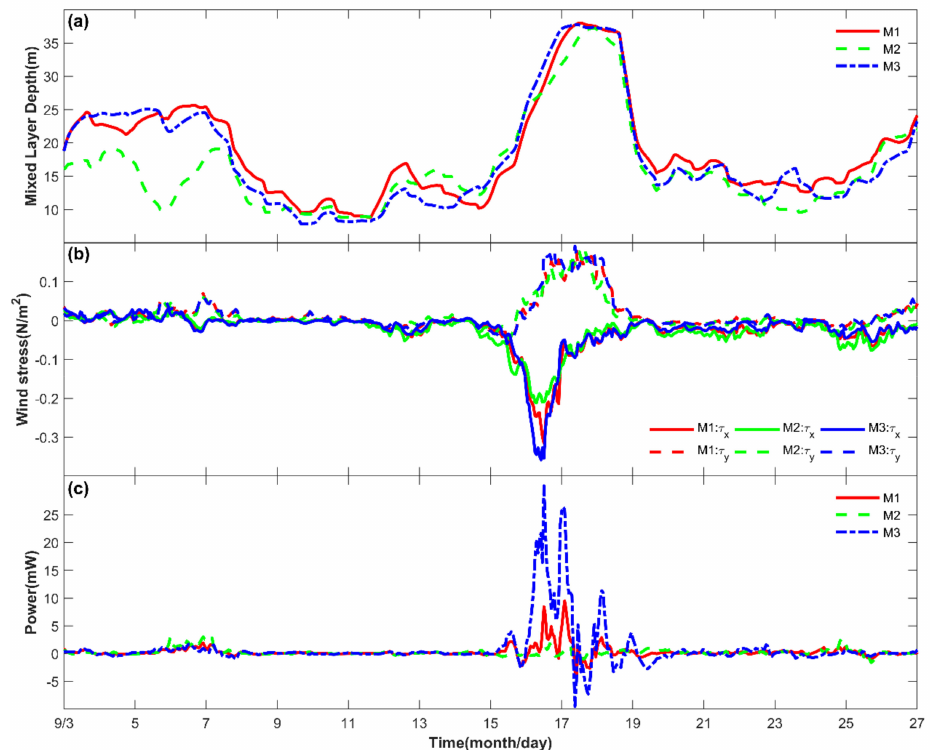
Figure 7. ( a ) The 25-h moving averaged mixed layer depths of M1, M2, and M3 based on the HYCOM dataset; ( b ) zonal (solid lines) and meridional (dashed lines) wind stress calculated from ERA5 dataset; and ( c ) near-inertial energy flux from surface wind stress to oceanic mixed layer obtained from the results of the damped slab